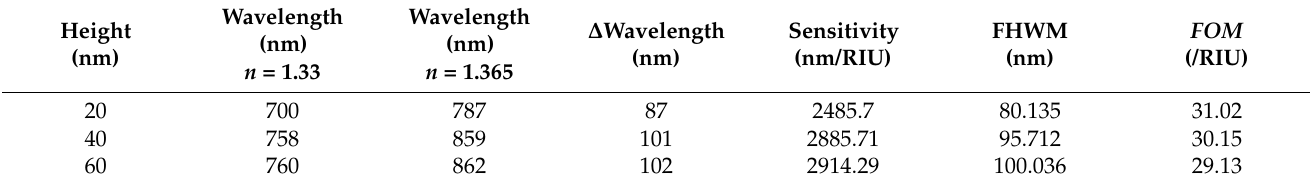
Table 4. Evaluation of the sensing performance for the different heights of the SiO 2